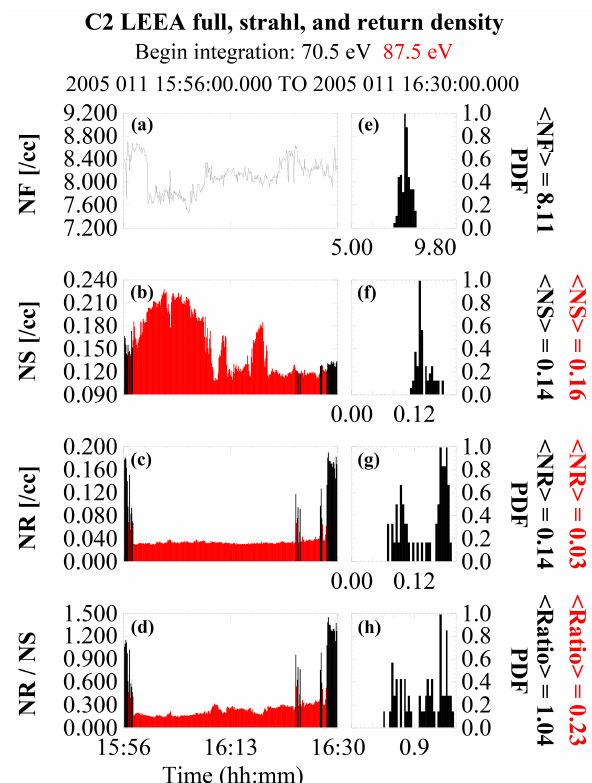
Figure 6. Electron density information across the 11 January 2005 event. From top to bottom, the total, strahl, and return electron den- sities and the ratio of the return to strahl density across the event. Panels (a–d) show the values as a function of time. The red por- tions in (b–d) show when the spacecraft was in the solar wind. Pan- els (e–h) are the corresponding PDF plots of the foreshock density only. The average foreshock and solar wind densities are shown to the right of each PDF plot (red solar wind, black foreshock). The beginning energy integration used to estimate the density in each region is shown at the